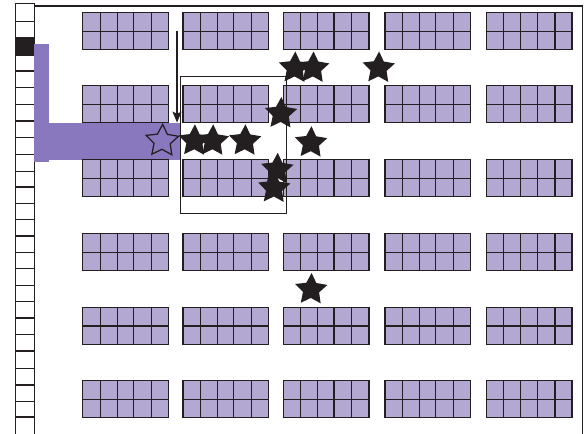
Figure 7: Situation of obstacles encountered by warehousing logistics robots.